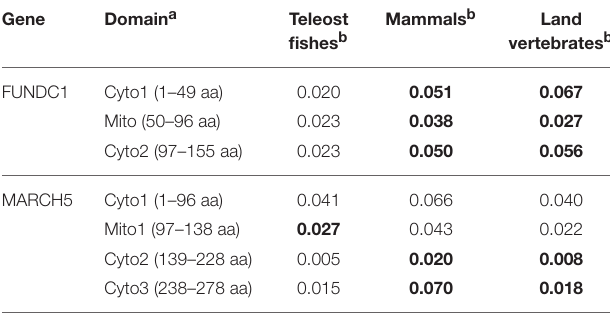
TABLE 3 | Estimation of dN and dS substitution rate variation across the entire gene sequences of FUNDC1, MARCH5, BNIP3, and NIX in the lineages of teleost fishes, mammals and land vertebrates.